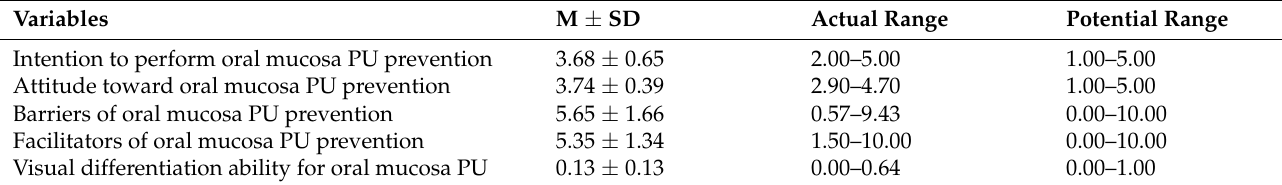
Table 2. Descriptive statistics of study variables (N = 112).